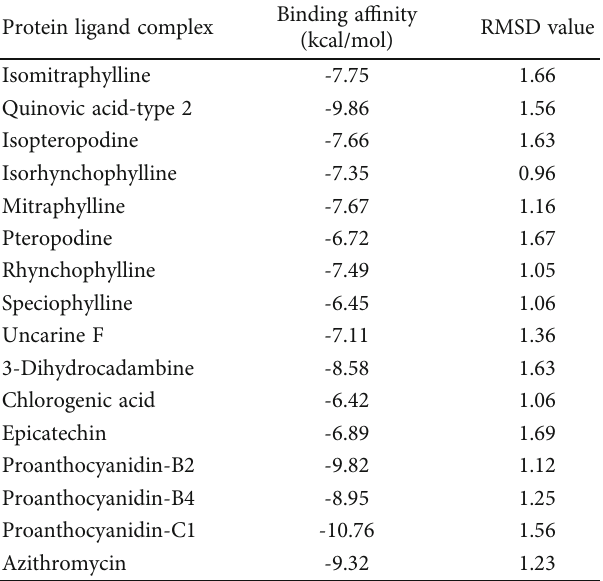
Figure 4: Mapping of the tested ligands on the generated pharmacophore(a) ligand: 3-dihydrocadambine ( fit value = 2 : 33 ), (b) ligand chlorogenic acid ( fit value = 2 : 30 ), (c) ligand isomitraphylline ( fit value = 2 : 56 ), (d) ligand isorhynchophylline ( fit value = 3 : 01 ), (e) ligand proanthocyanidin- B2 ( fitvalue = 3 : 01 ), (f) ligand proanthocyanidin-C1 ( fit value = 2 : 98 ), (g) ligand rhynchophylline ( fitvalue = 2 : 43 ), (h) ligand uncarine F ( fitvalue = 3 : 12 ), and (i) ligand speciophylline ( fitvalue = 2 : 56 ). Table 2: Best binding energy (kcal mol – 1 ) based on BIOVIA Discovery Studio scoring of the main constituents of the U. tomentosa into SARS-CoV-2 Omicron spike protein-binding domain (PDB ID: